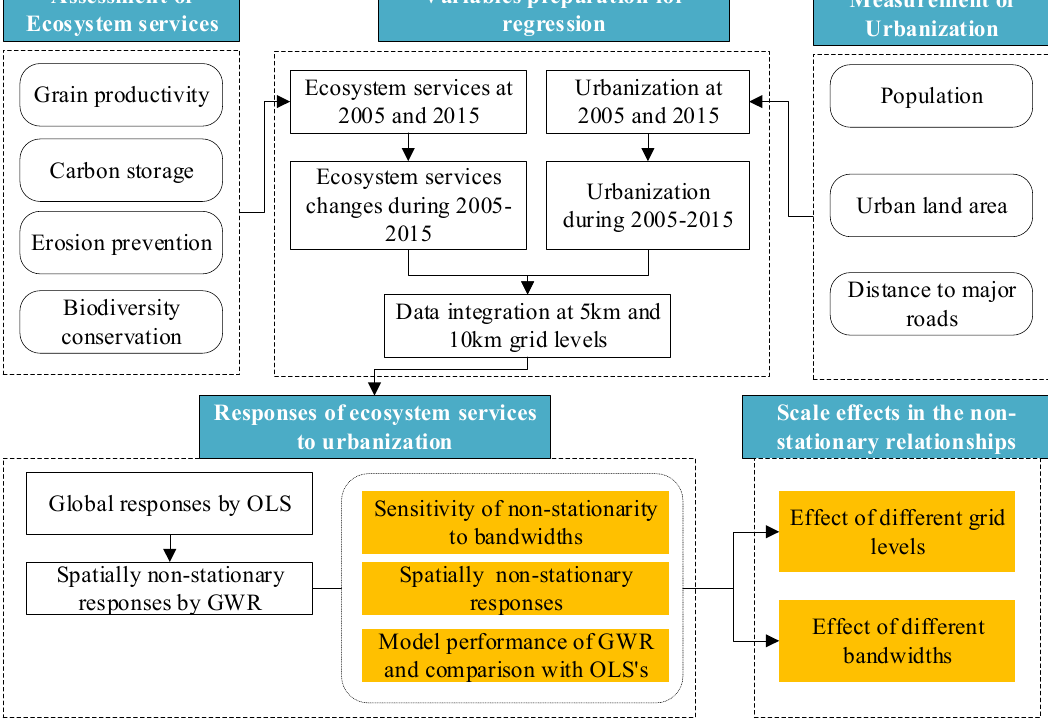
Figure 2. Flow chart of the method.